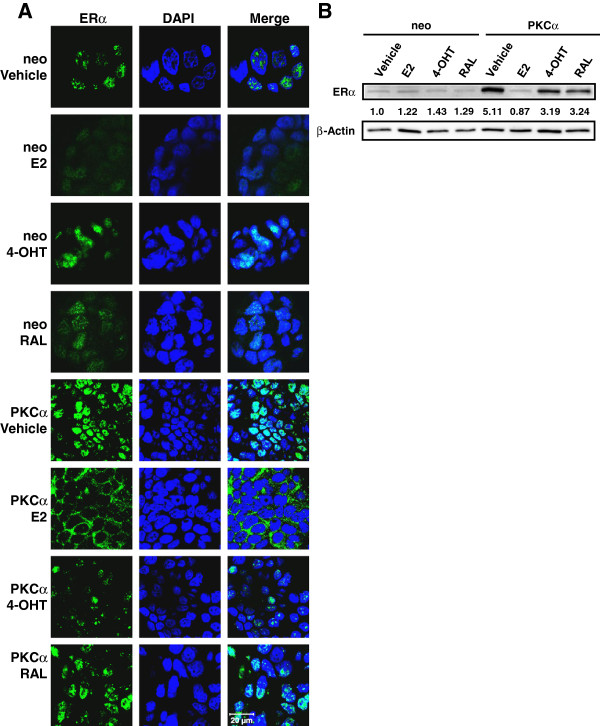
E2 induces complete relocalization of ERα in established T47D:A18/PKCα colonies after 10 days. A. T47D:A18/neo colonies (neo) and T47D:A18/PKCα colonies (PKCα) colonies were immunostained for ERα (green) and nuclei (blue). All images were acquired and processed using parameters described in materials and methods. Colonies were grown for 10 days then treated for 10 days with vehicle (EtOH, 0.1%), E2 (10-9 M), 4-OHT (10-7 M) or RAL (10-7M). Scale bar = 20 μm. B. Expression of ERα in whole cell colony lysates. Molecular weights of ERα and β-actin are 67 kDa and 42 kDa, respectively. Values represent β-actin-normalized ERα expression relative to T47D:A18/neo E2-treated colonies.